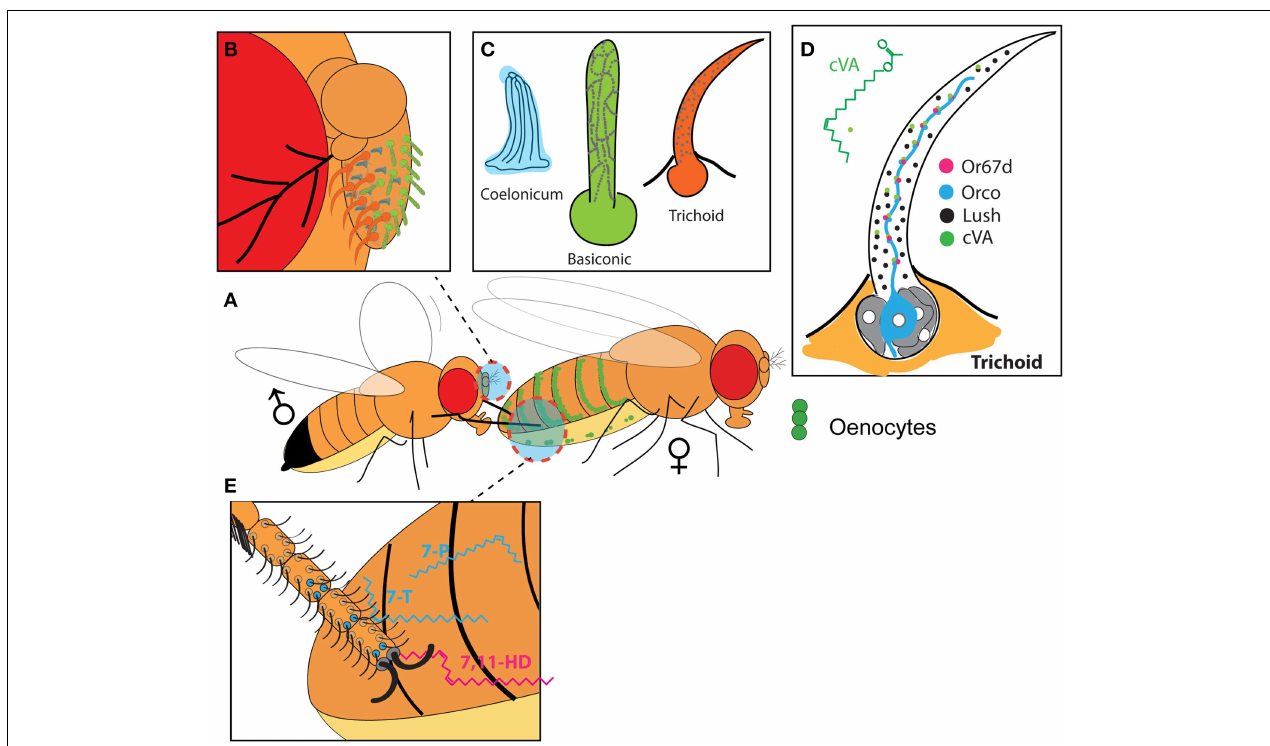
FIGURE 1 | Pheromonal system of Drosophila melanogaster . (A) A male engaging in courtship with a female taps her abdomen using his first pair of legs. The female abdomen contains cells called Oenocytes (green dots). (B) The olfactory system is located in the third antennal segment, and (C) is made of three distinct sensillum-types that differ in morphology. (D) The trichoid sensilla are a site of pheromone detection. The pheromone cVA (green dot) enters the sensillum and is bound to the Odorant Binding protein Lush. Lush is secreted by support cells